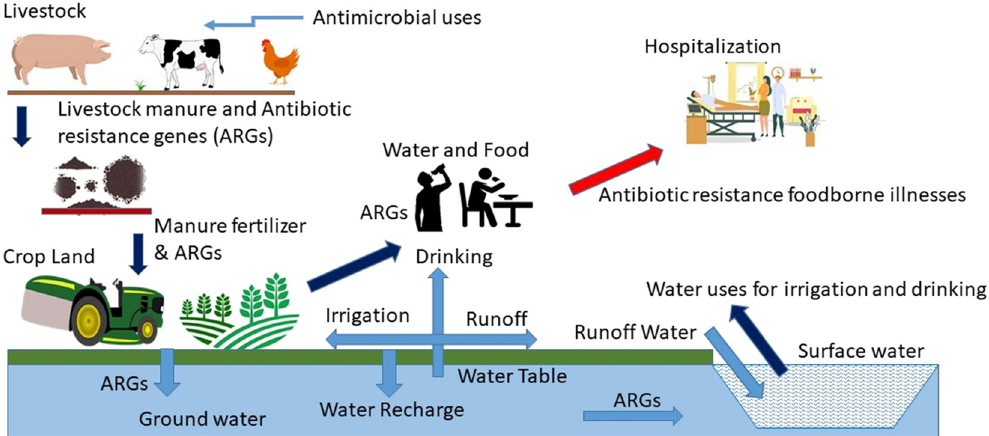
Figure 1: Livestock manure, manure application to cropland, and potential transfer of antibiotic resistances from manure to the ambient water and environment, and consequential public health